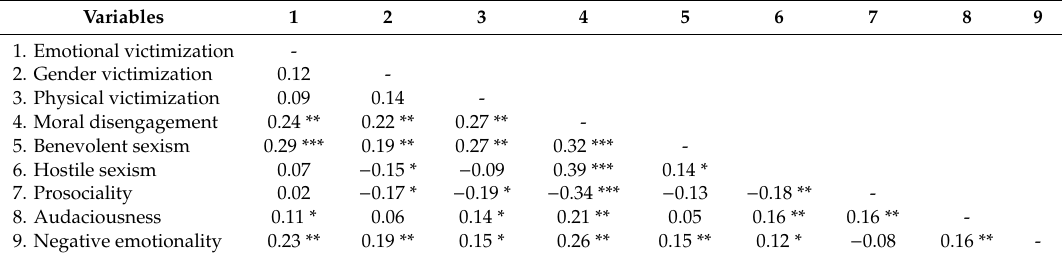
Table 2. Correlations in all the